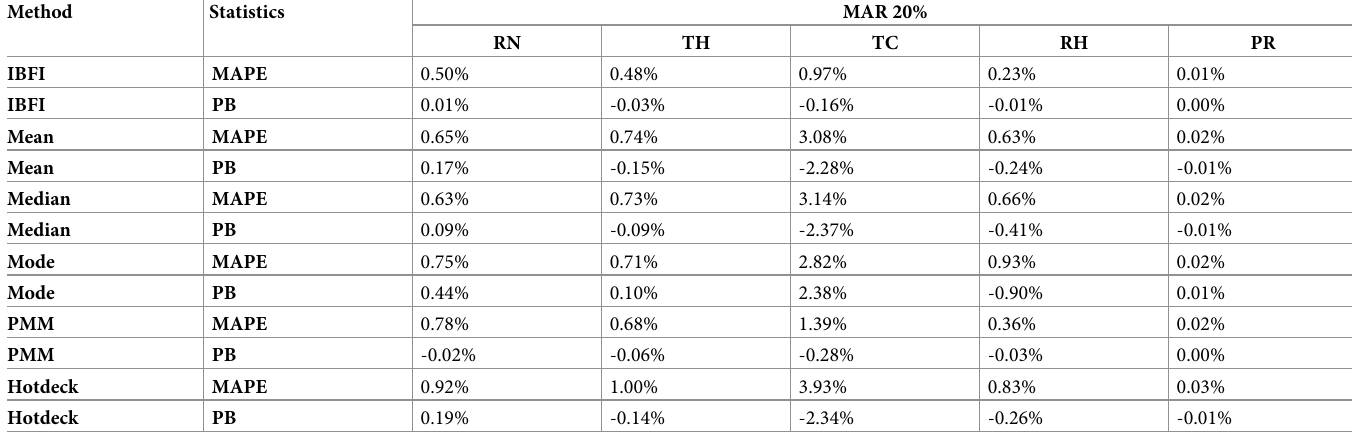
Table 3. MAPE and PB statistics for IBFI compared with other imputation methods (mean, median, mode, PMM, and Hotdeck) for 20% missingness of type MAR and all parameters tested (RN, TH, TC, RH, and PR).